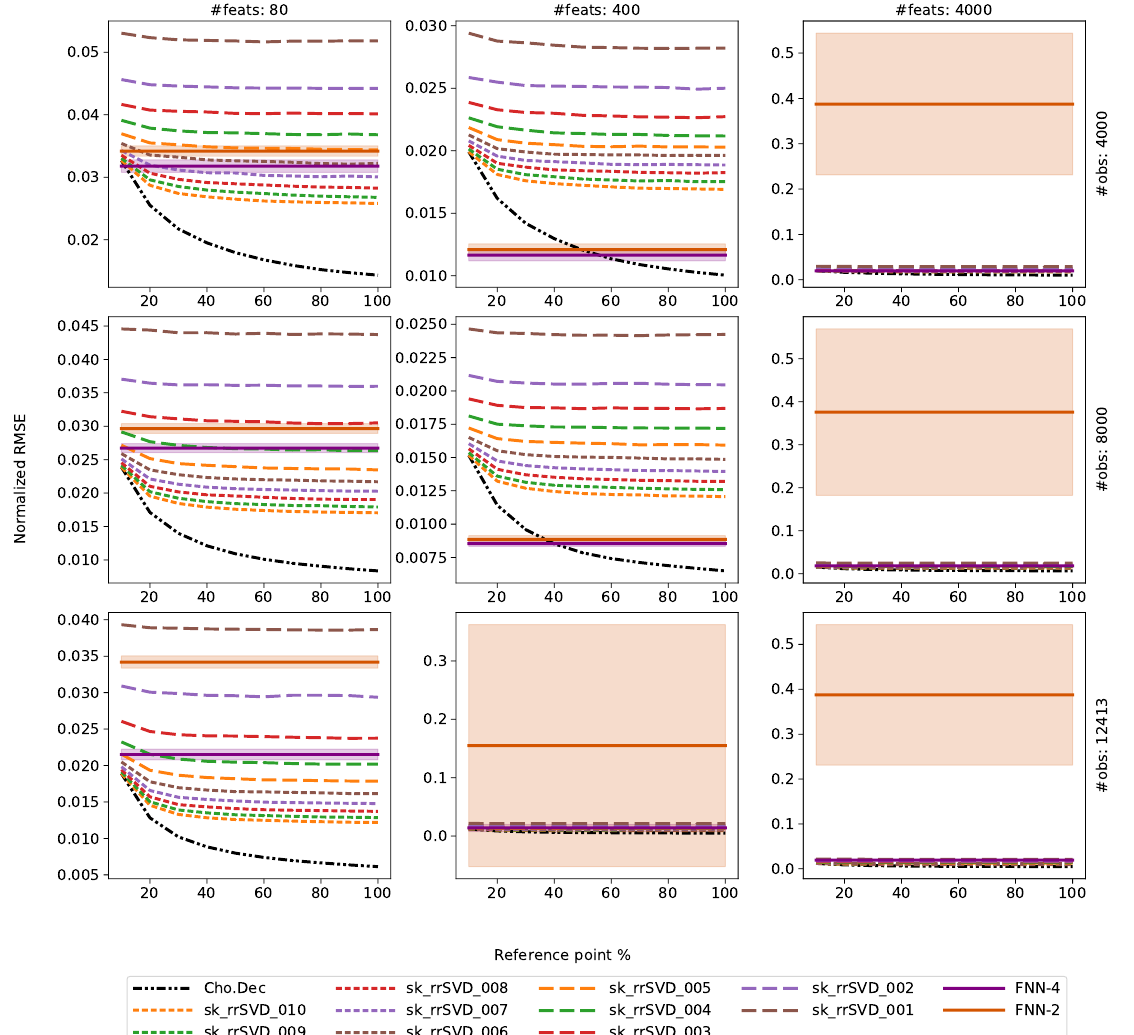
Figure A7. Normalized RMSE for Au 38Q . Each subfigure has reference point percentage on the horizontal axis and normalized RMSE on the vertical axis. The top row corresponds to dataset variants with 4000 observations, middle row represents variants with 8000 observations and the bottom row is for the full dataset. The left column represents dataset variants with 80 features, middle represents 400 features and the right column is for the full feature set. Please note that the Y–axis is different in each